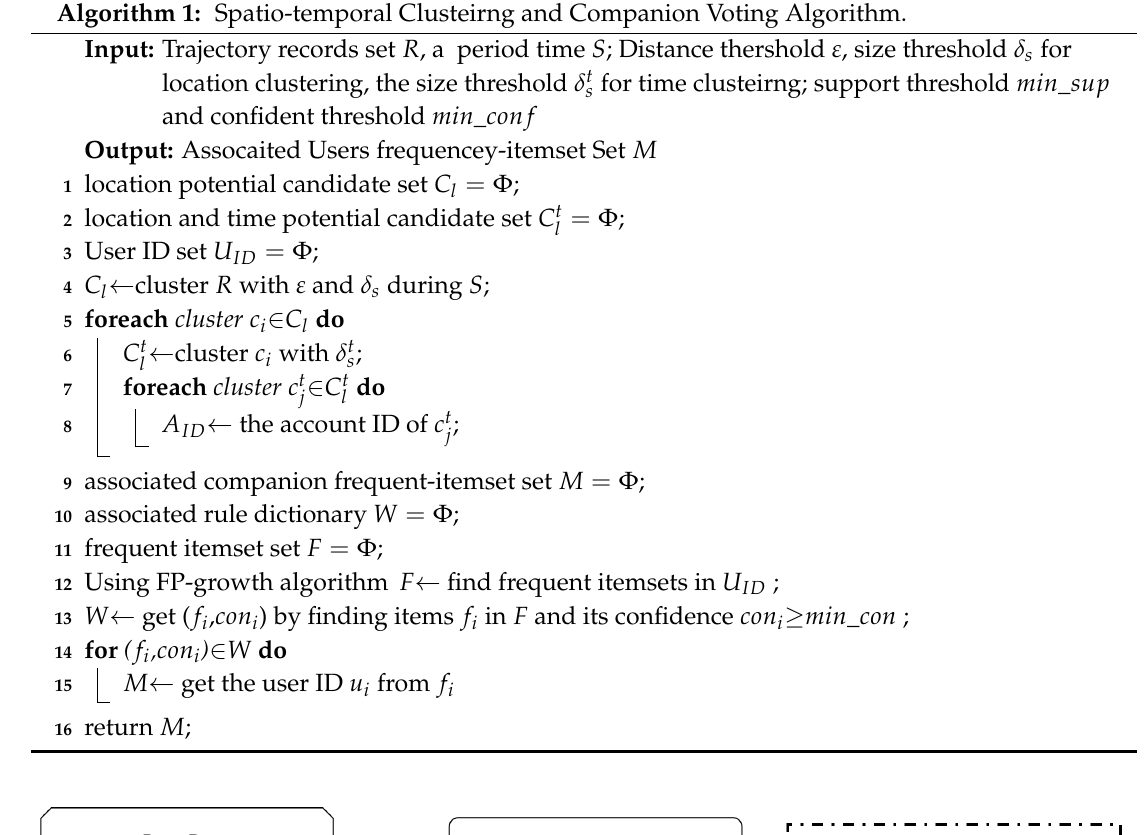
Algorithm 1: Spatio-temporal Clusteirng and Companion Voting Algorithm.